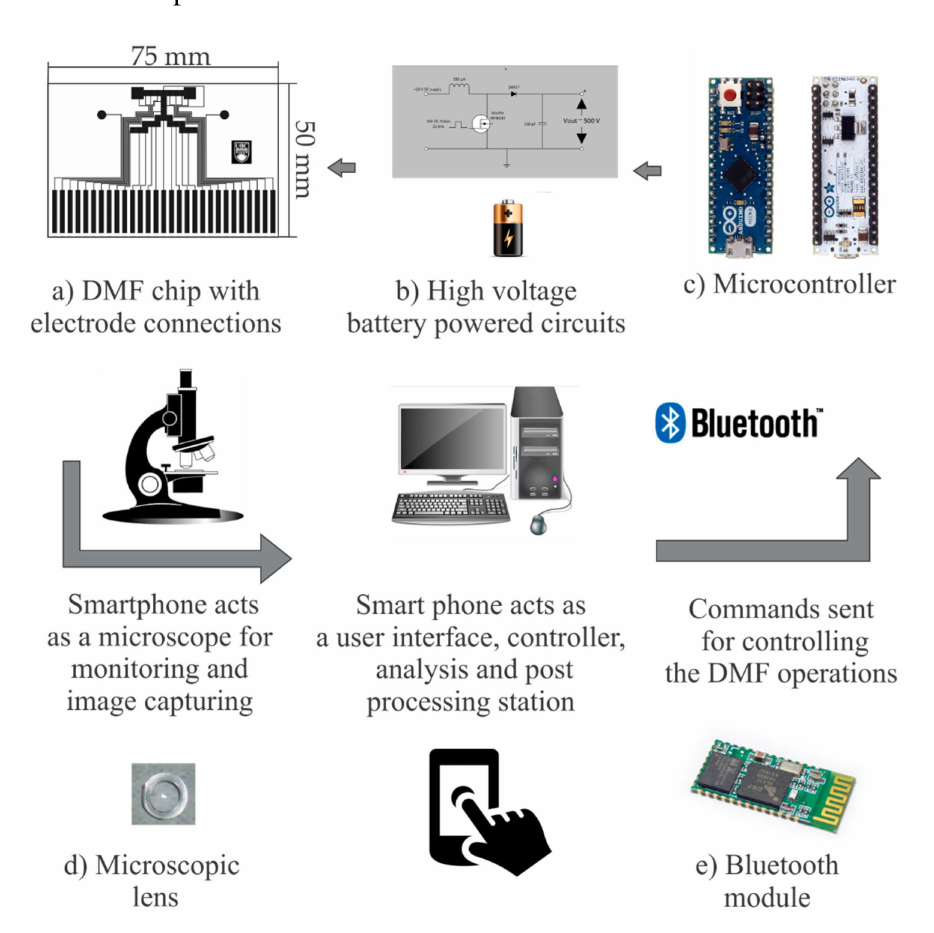
Figure 1. A schematic hierarchy of the proposed ultra-compact digital